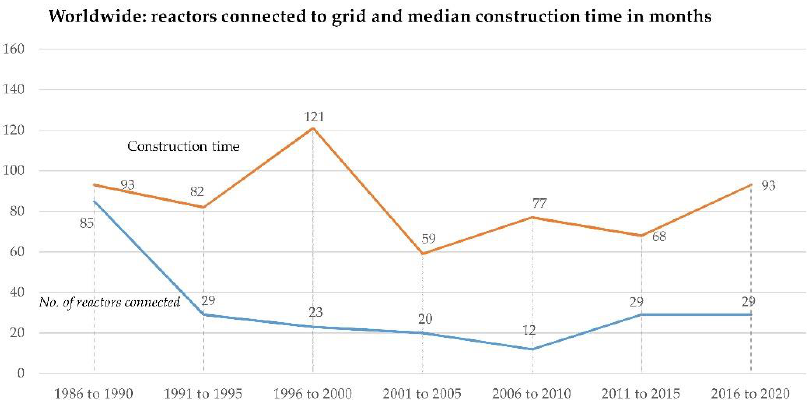
Figure 2. Construction time (years) of nuclear power plants (2006–2016). Source: authors according to [29].